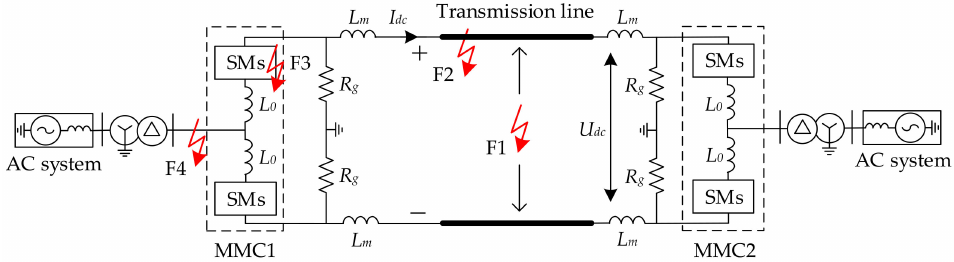
Figure 1. Diagram of a modular multilevel converter-based high-voltage direct current